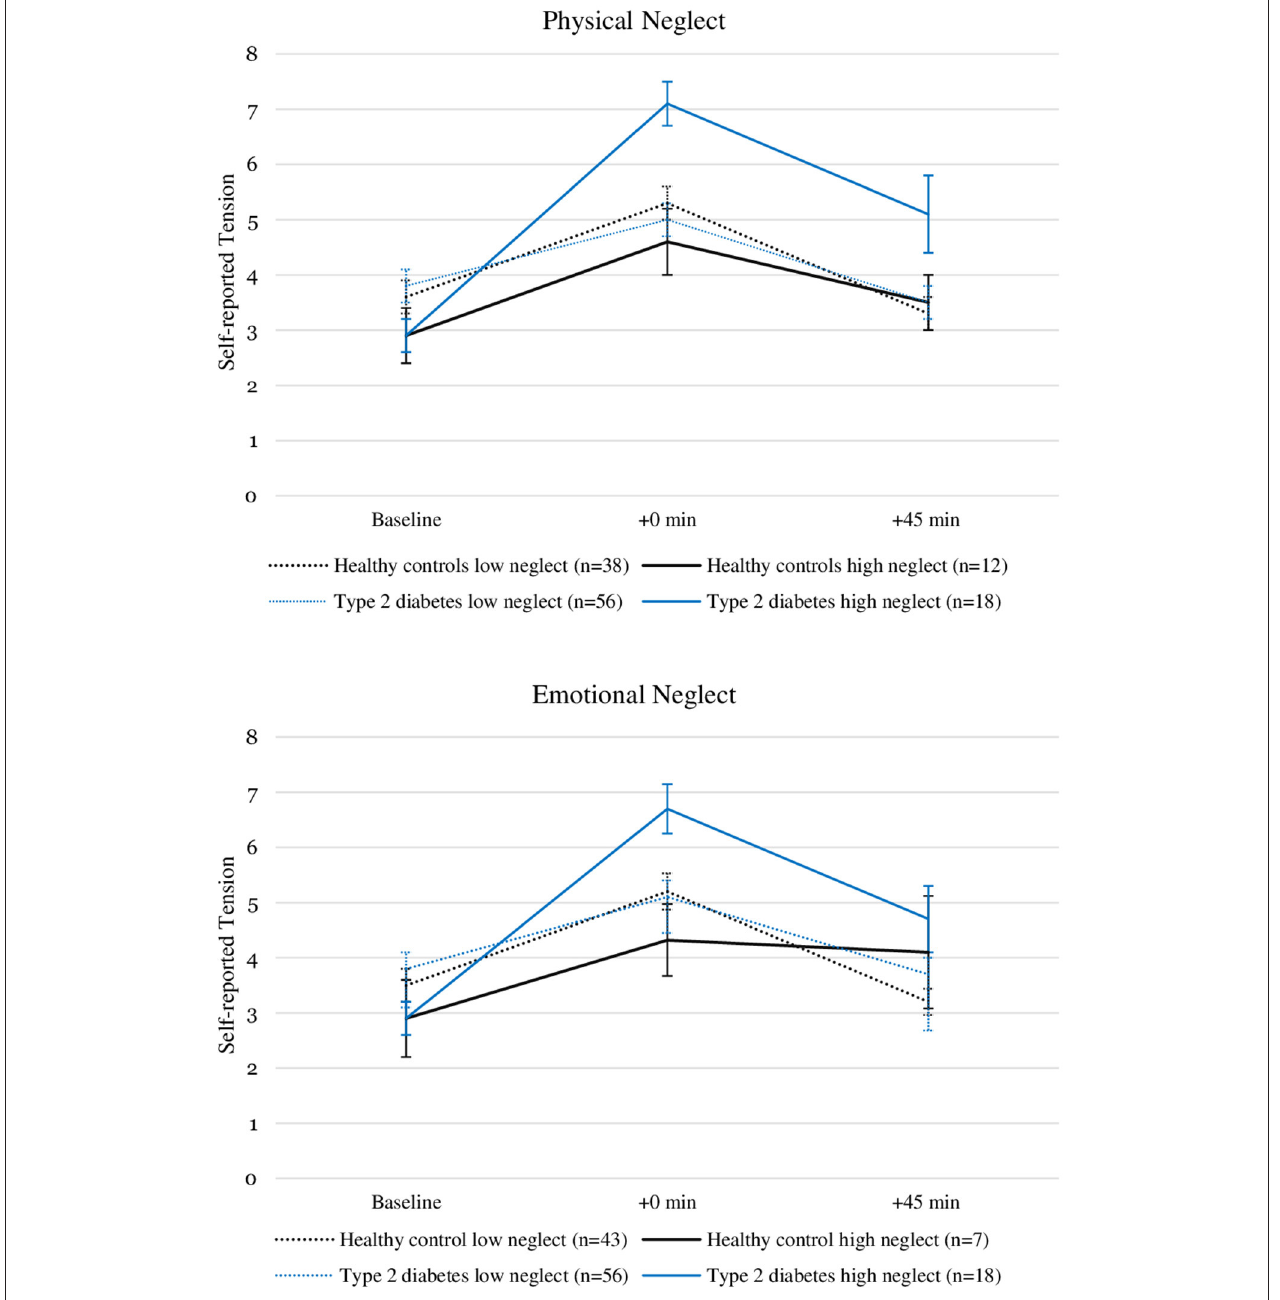
FIGURE 1 | Self-reported tension levels before and after stress induction in patients with type 2 diabetes and healthy controls with and without the experience of “moderate to severe” childhood physical and emotional neglect. Depicted are average values and standard errors. Details on the descriptive values displayed in the figure can be found in the Supplementary Material